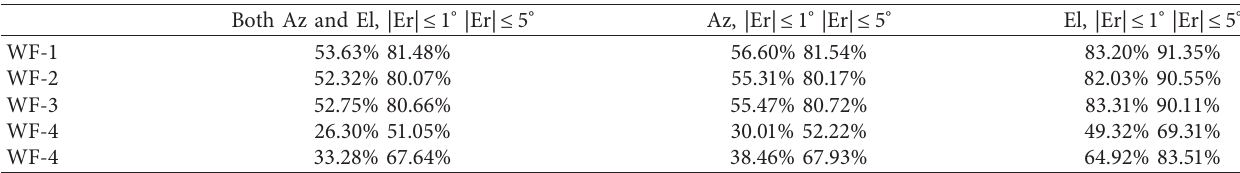
Table 8: Array-3 probability of AoA estimation using 1025 snapshots ( − 10dB ≤ SNR ≤ 0dB and last line using 513 snapshots).